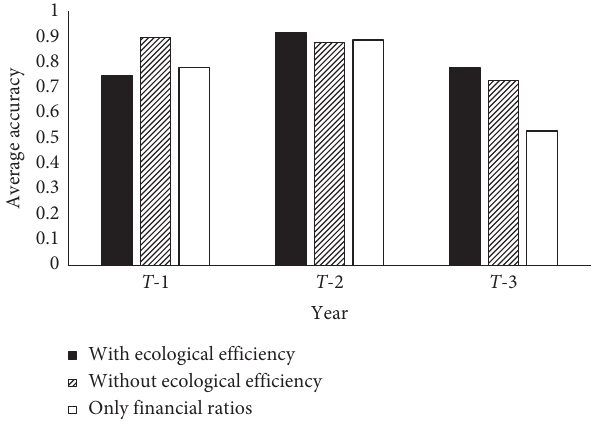
Figure 3: Comparison of average accuracy of ANNs. Table 4: Levene variance equality test and T -test of efficiency